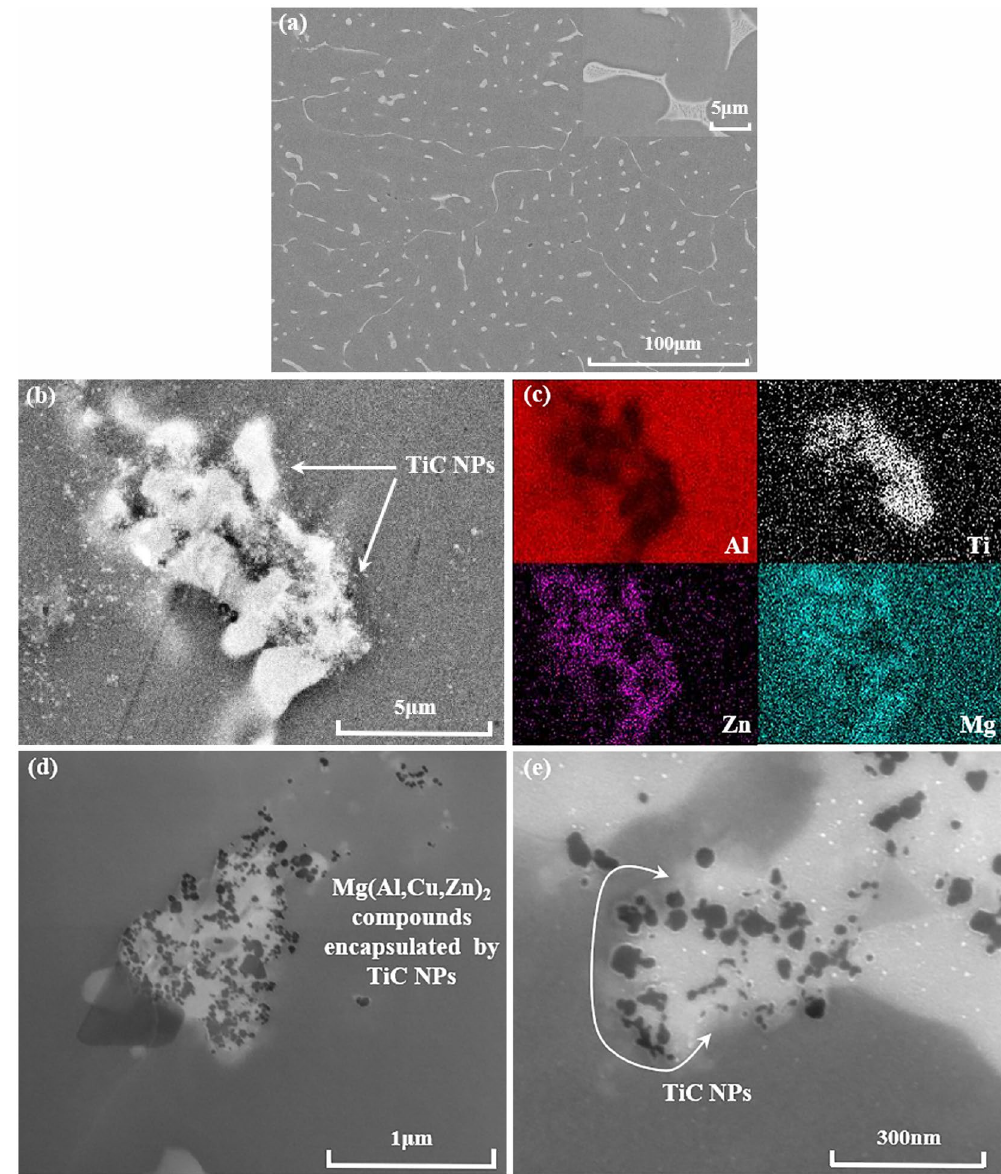
Figure 7. FESEM characterizations of secondary Mg(Al,Cu,Zn) 2 phases in AA7075 alloys before and after nano-treatment. ( a ) Secondary phase in pure AA7075 alloys (partial enlargement illustrated in the upper right corner); ( b ) modified secondary phase in AA7075 by TiC NPs; ( c ) the X-ray images for elements Al, Ti, Zn and Mg in ( b ); ( d , e ) modification features of secondary phases by TiC